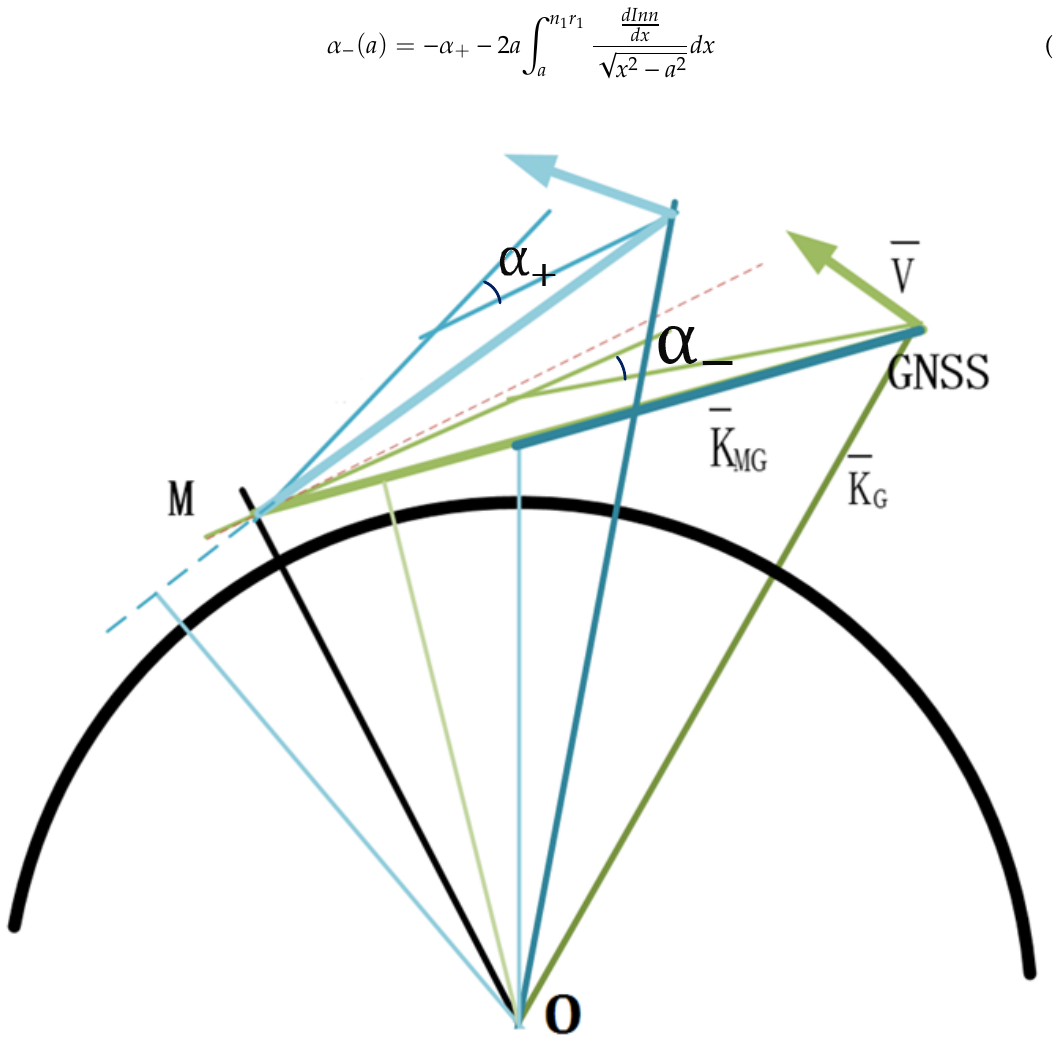
Figure 1. Schematic diagram of mountain base inversion. M stands for the top of the mountain, where the antenna and receiver are installed, and Global Navigation Satellite System (GNSS) stands for the navigation satellite we want to receive, that is, the navigation satellite that generates the occultation event.